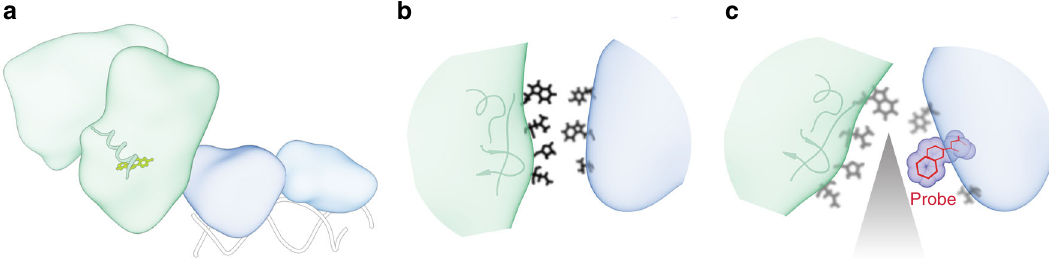
Fig. 5 Multidomain architecture and cross-talk at the domain interface of the hER α . a The hER α homodimeric complex contains both LBDs (green) and DBDs (blue). A hormone ligand (yellow) is capped underneath the LBD ’ s C-terminal helix H12 (ribbon). b The LBD – DBD interface consists of the LBD ’ s two β -strands, distant from the ligand-binding pocket and coactivator-binding sites. Disruption of this interfacial cross-talk, which serves as an allosteric channel to transmit the signaling of ligand binding from the LBD to a distant DBD, suppresses hormone-induced transcription. c Alteration of the domain cross-talk at the structural level is monitored by intrinsic tryptophan fl uorescence (i.e., Trp200 in the middle of the interface as a probe in red blobs),